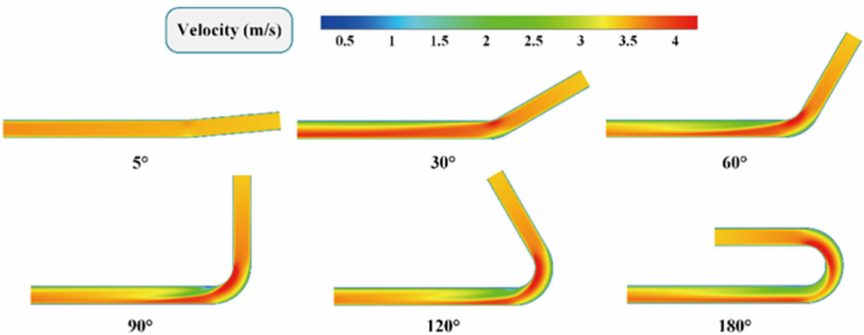
Figure 5. Velocity distribution of bend pipe with different bending